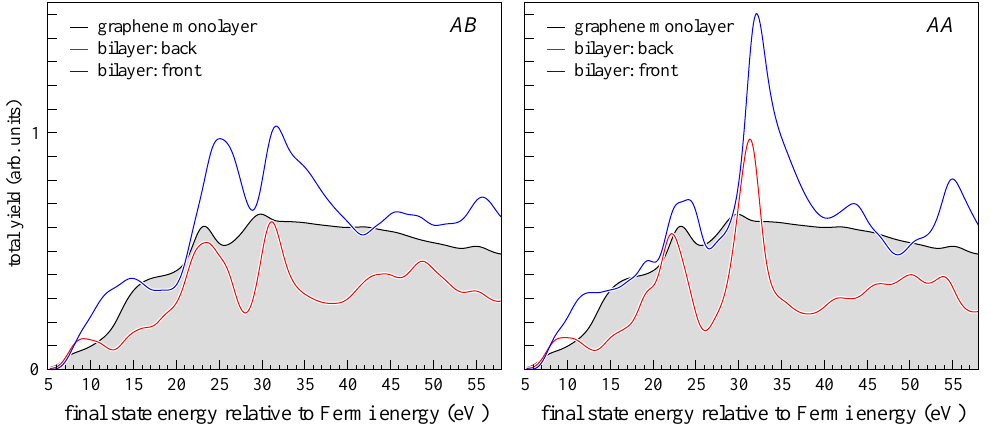
Figure 5. Photoyield from the graphene monolayer (black line with shaded area), the back (red), and front (blue) layer of the bilayer. ( Left ): AB stacking, ( right ): AA stacking. Shown is the k || -integrated intensity over the circle of 2 Å − 1